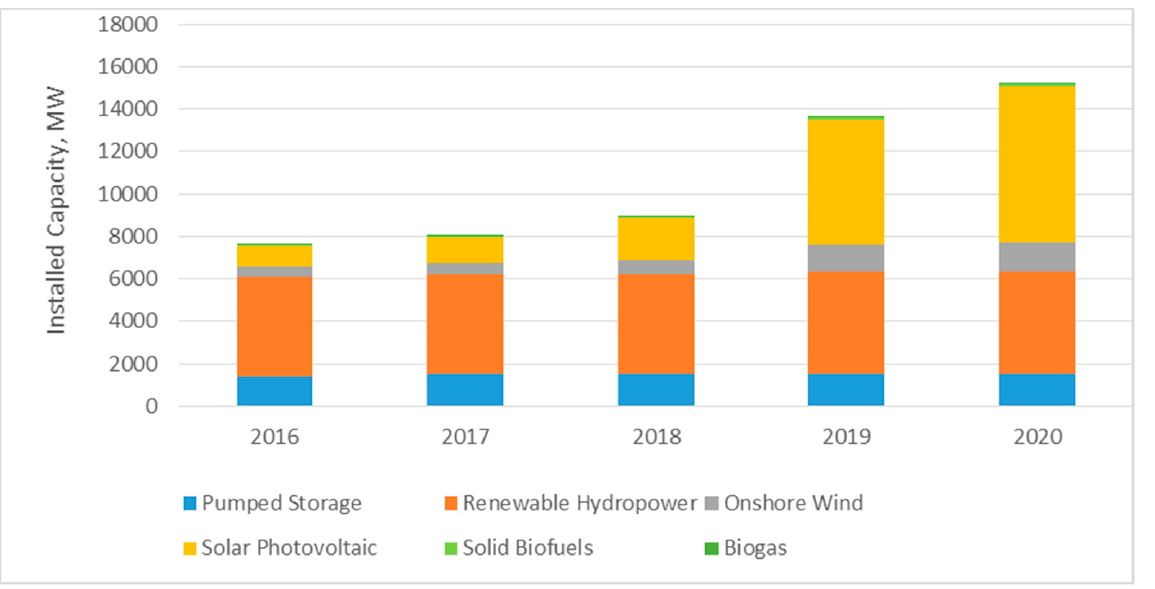
Figure 3. Dynamics and structure of growth of the installed capacity of technologies based on renewable energy sources in Ukraine in 2016–2020 (IRENA).